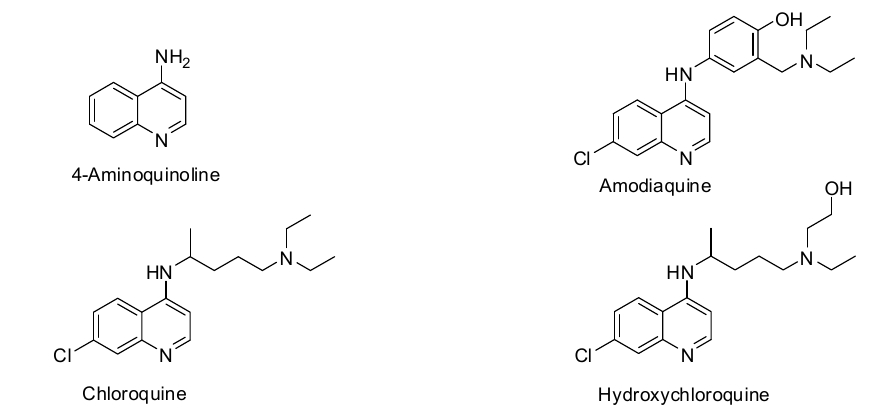
Figure 1. Aminoquinoline and their derivatives as antimalarial agents.